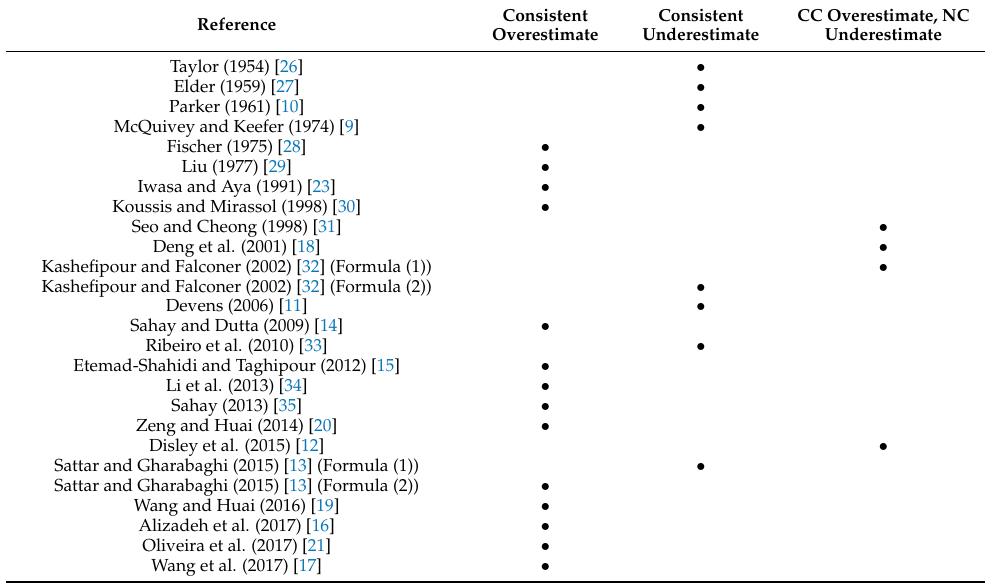
Table 7. Comparison of the longitudinal dispersion coefficients obtained from the 26 evaluated formulae in relation to observed